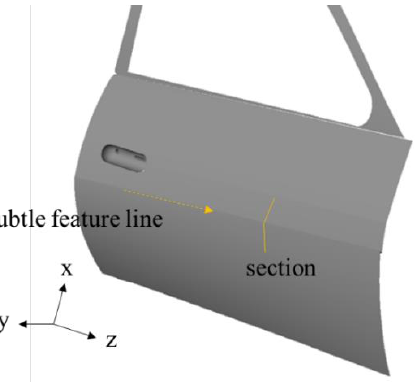
Figure 1. Subtle feature line on a door panel.